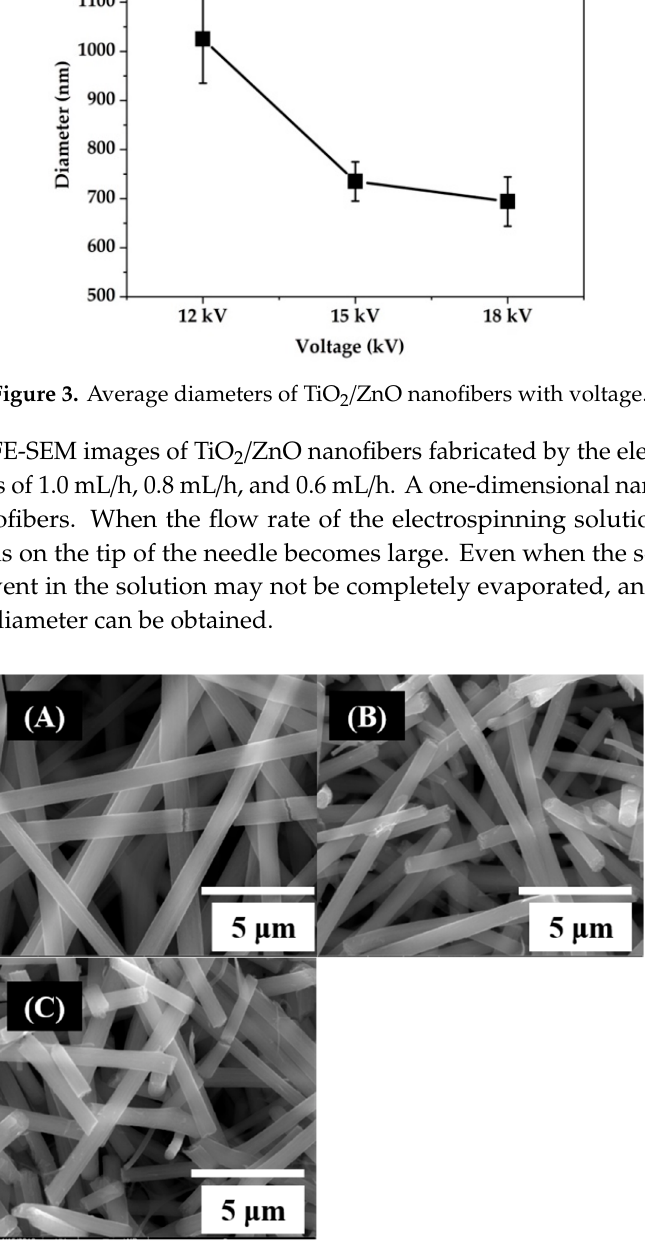
Figure 4. FE-SEM images of electrospinning TiO 2 / ZnO nanofibers: ( A ) 1 mL / h, ( B ) 0.8 mL / h, and ( C ) 0.6 mL / h.